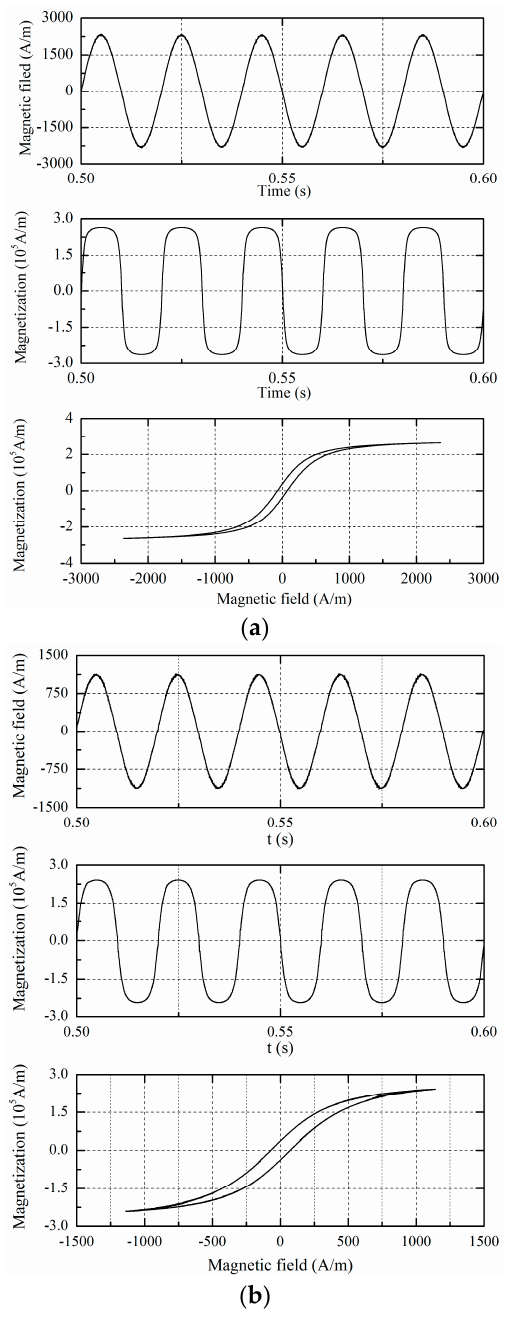
Figure 6. Relationship between the magnetic field and magnetization; ( a ) (cid:1848) (cid:3036)(cid:3041) = 110 V ; and ( b ) (cid:1848) (cid:3036)(cid:3041) = 220